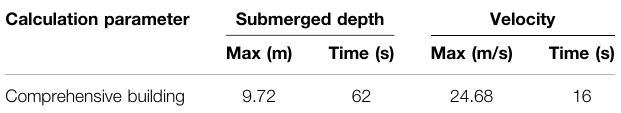
TABLE2| Resultsofthedownstreamsensitivetargetforthe#1tailingsdamfailure simulation. Calculation parameter